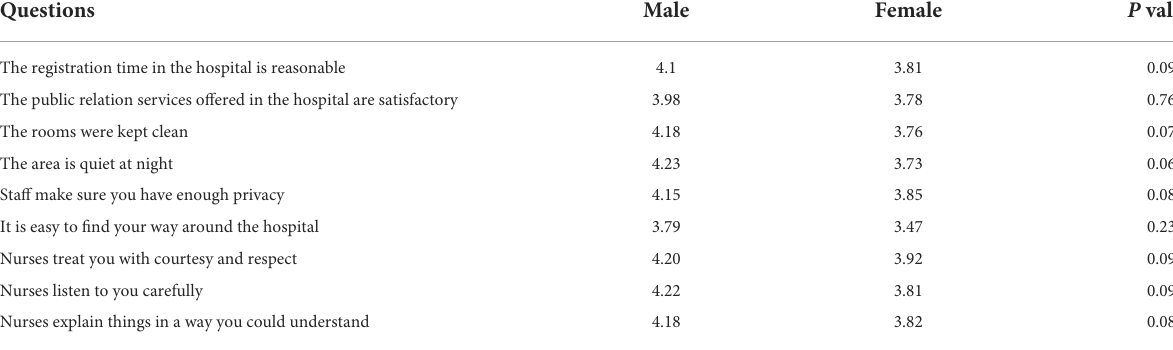
TABLE 2 Satisfaction with the general healthcare and nursing services.